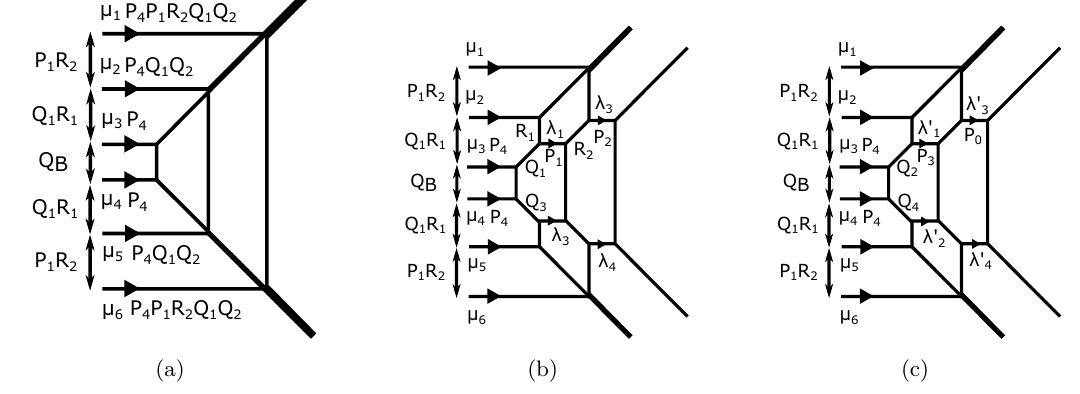
Figure 38. Parametrization of the web diagram for the geometry e (1)